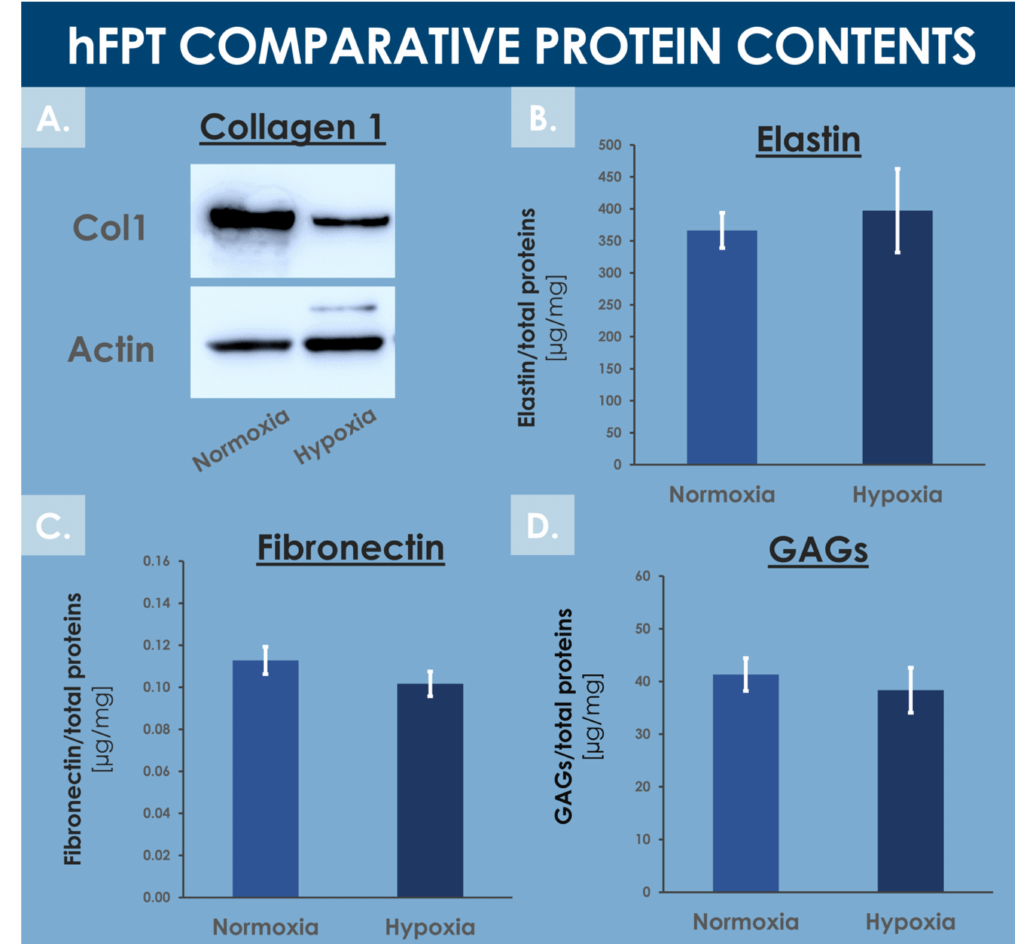
Figure 8. Comparative data relative to specific hFPT lysate protein contents in the normoxia incubation condition and in the hypoxia incubation condition. ( A ) Western blotting revealed a relatively lower collagen 1 content in the hypoxia sample group. Whole gel imaging can be found in Supplementary Materials, Figure S2. ( B ) Colorimetric measurements revealed conserved total elastin quantities in both sample groups (i.e., equality of variances and means, p = 0.157). ( C ) ELISA results revealed conserved total fibronectin quantities in both sample groups (i.e., equality of variances and means, p = 0.417). ( D ) Colorimetric measurements revealed conserved total GAG quantities in both sample groups (i.e., equality of variances and means, p = 0.304). ELISA, enzyme-linked immunosorbent assay; GAG, glycosaminoglycan; hFPT, human fetal progenitor